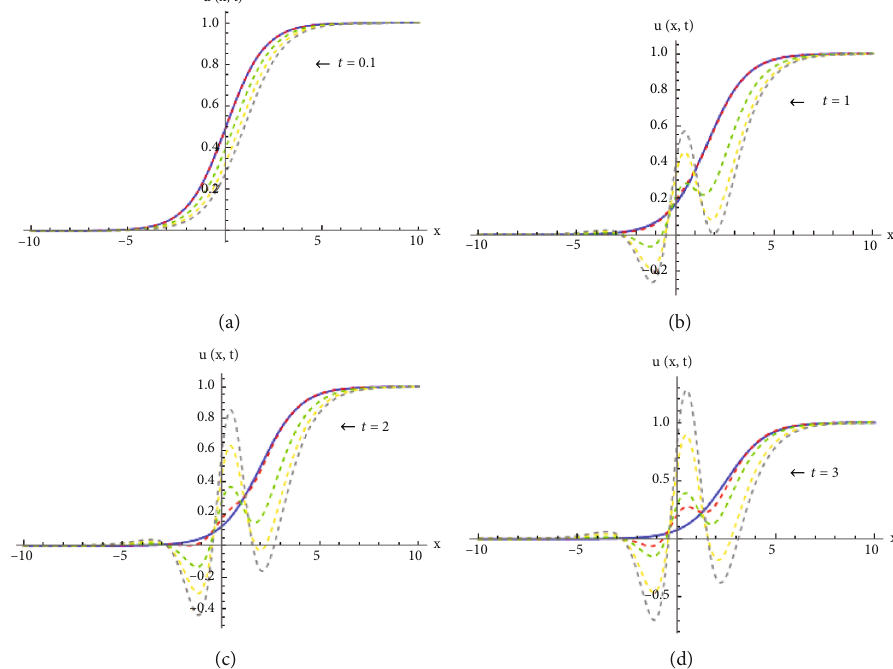
Figure 1: Surface wave behavior of u (d) α = 0 : 25 .